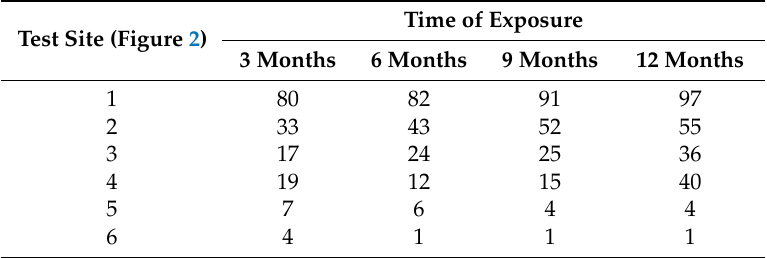
Table 5. Evolution with exposure time of the percentage coverage of the cuprite patina by basic copper chlorides. Information corresponding to the seaward facing specimen side at the different testing stations.